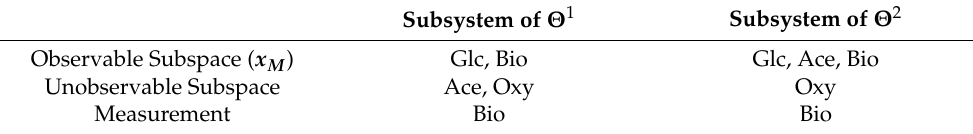
Table 1. Observable and unobservable subpace of two subsystems of the DFBM model of E. coli